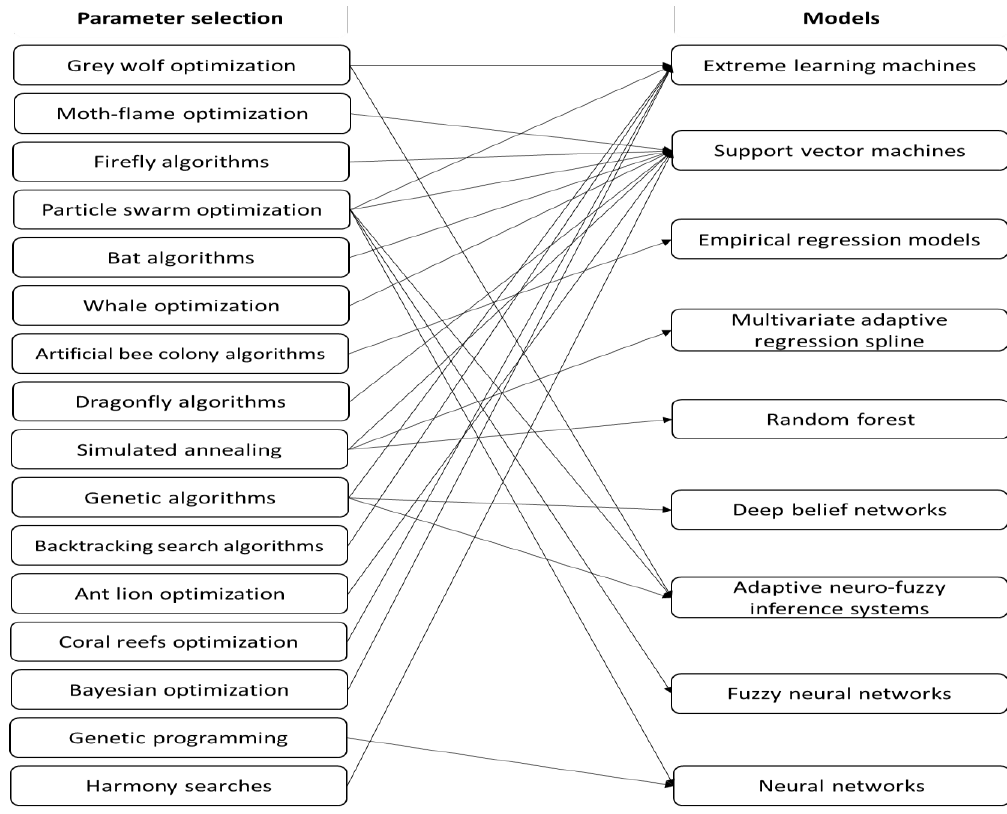
Figure 2. Metaheuristics for machine-learning parameter selection in renewable-energy predictions.